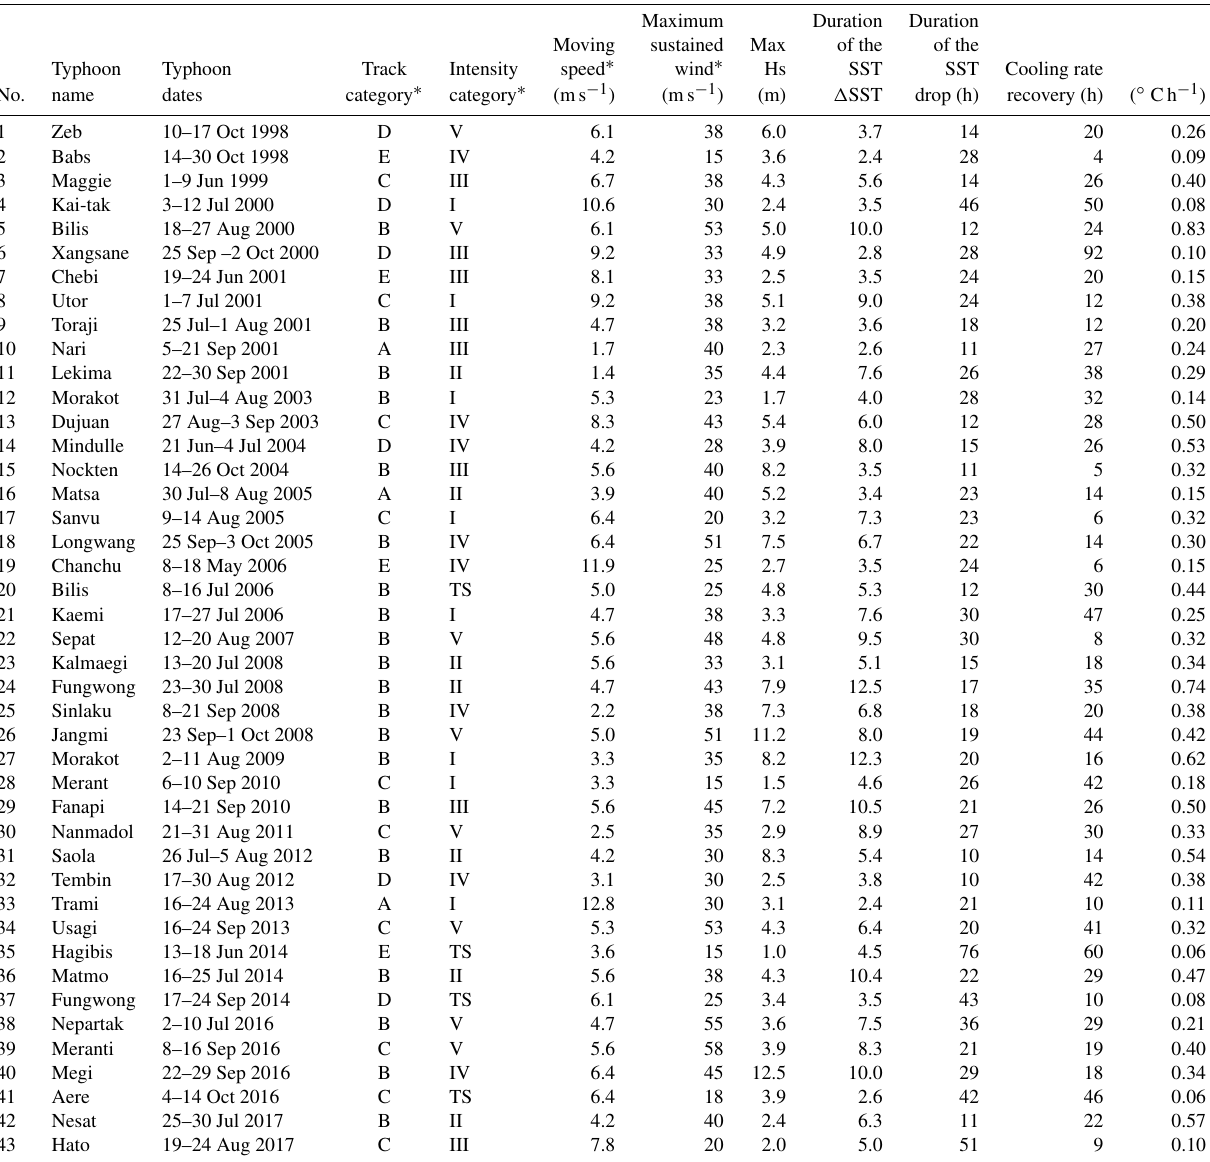
Table 3. Significant SST drops observed at the Longdong Buoy (NE Taiwan coast) during 43 typhoon passages from 1998 to